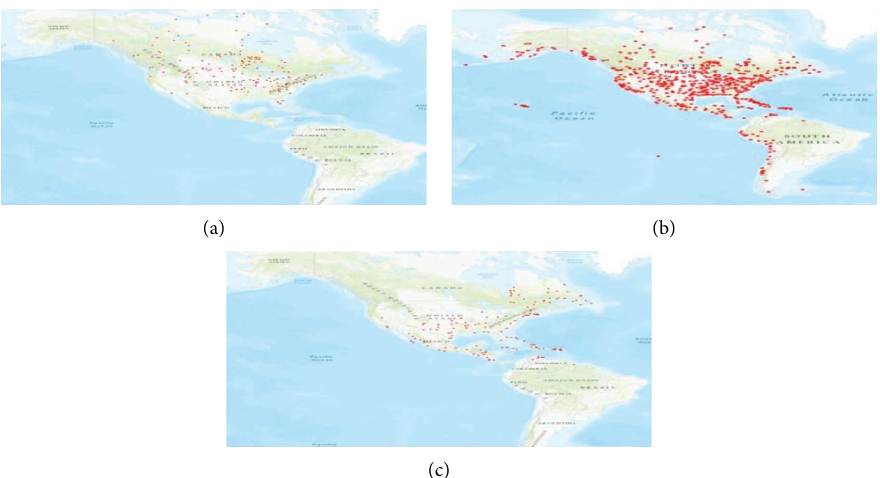
Figure 7: LCC of the North America-Caribbean component after its isolation from the network. Te red dots are the remaining airports after attacks on the world air transportation network (a) strength attack, (b) weighted betweenness attack, and (c) weighted PageRank attack. Te airports in the LCC isolated by the strength and weighted PageRank attacks are concentrated in the US and a small part of Canada. In contrast, airports are scattered in all the areas covered by the initial component after the weighted betweenness attack.